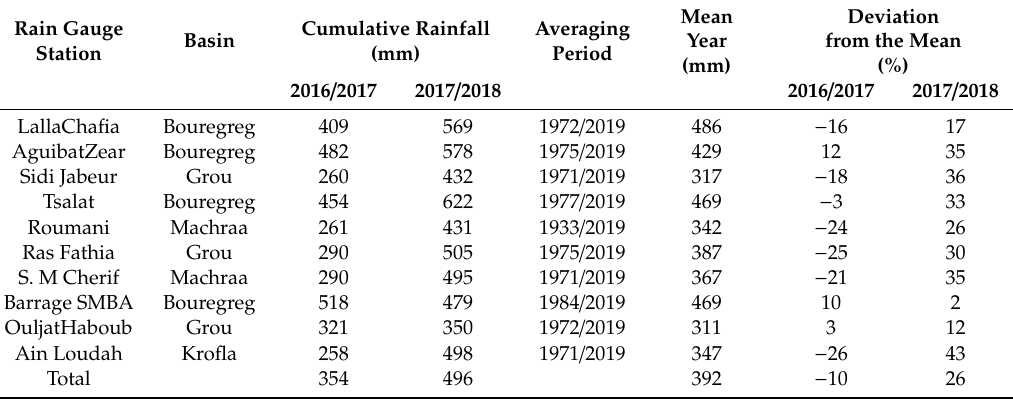
Table 6. Rainfall for the 2016 / 2017 and 2017 / 2018 water